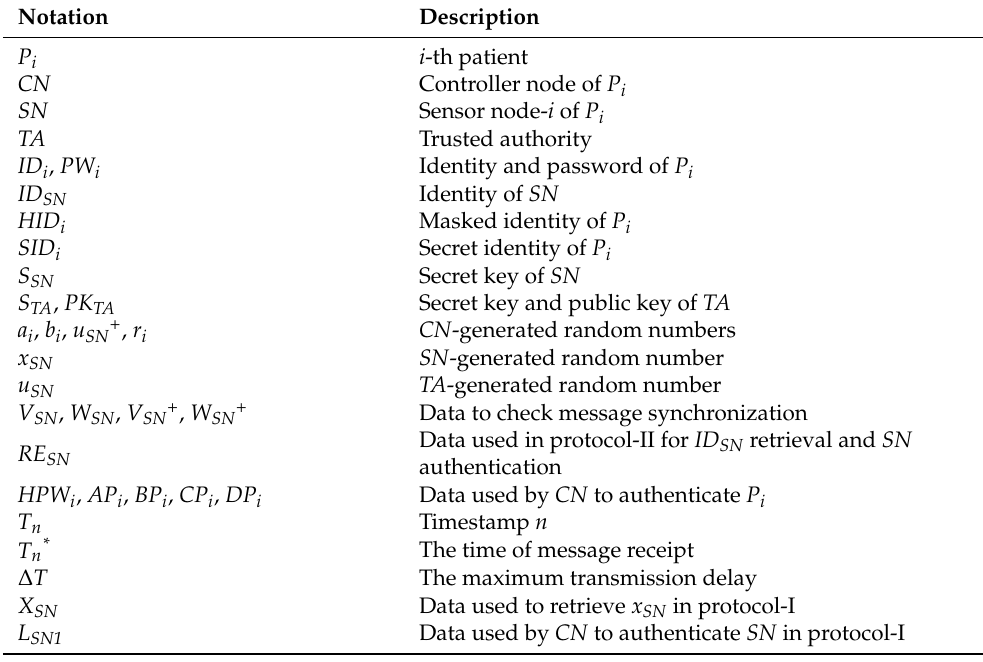
Table 1. Notations that are used in the proposed